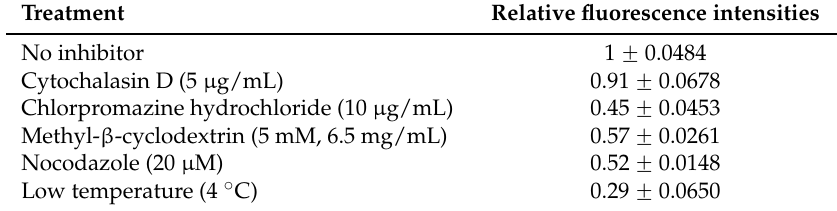
Table 1. Relative fluorescence intensities of cellular up ‐ taken dextran carrier with endocytosis inhibitors.